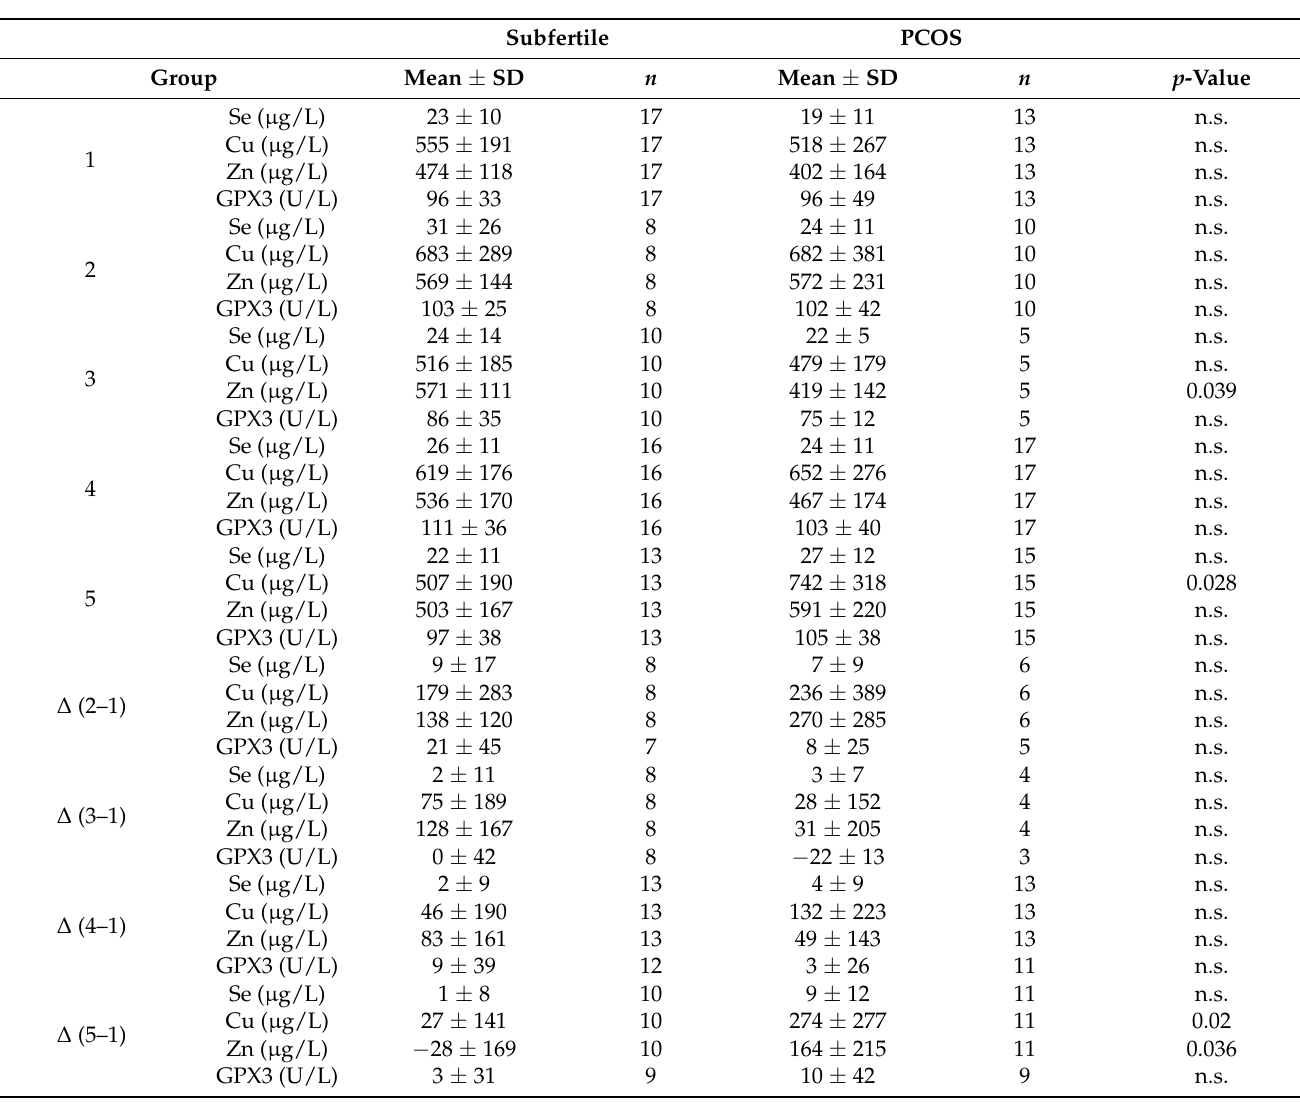
Table 2. TE concentrations in FF of different quality from women with or without